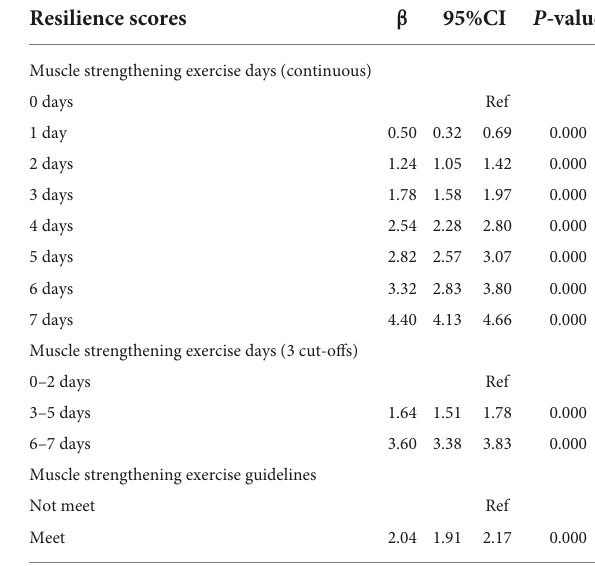
TABLE 3 Results for the associations between muscle strengthening exercise and resilience